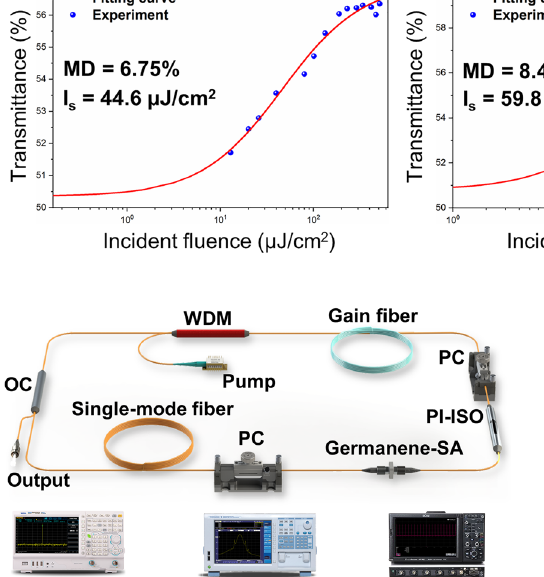
Figure 4: The measurement of nonlinear saturable absorption property. (A) The setup of balanced twin-detector measurement for the nonlinear saturable